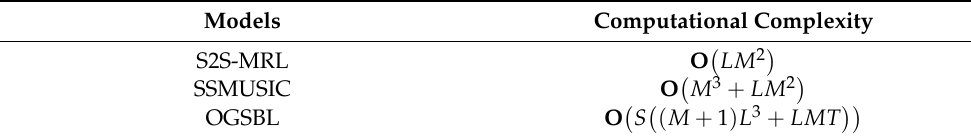
Table 5. Comparison Table of Calculation Complexity of Different Methods.